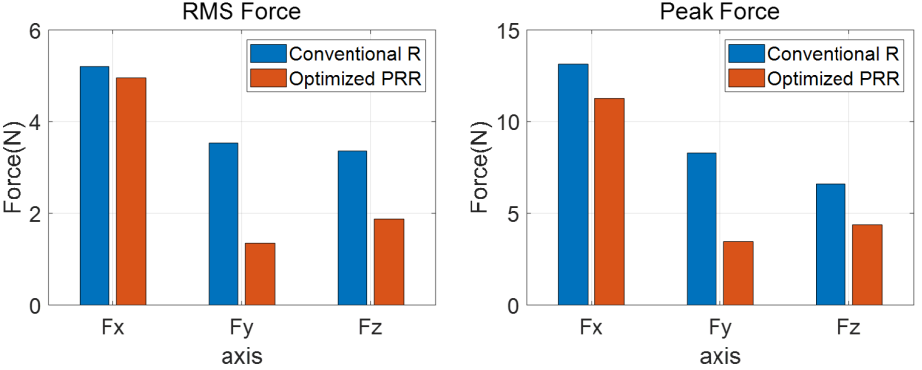
Figure 13. Root mean square (RMS) and peak magnitude of each triaxial force for a total of six motions.